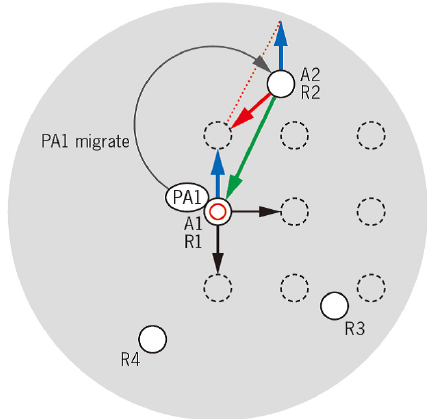
Fig. 5. A1 generates a pheromone agent and attracts A2 with its robot R2.